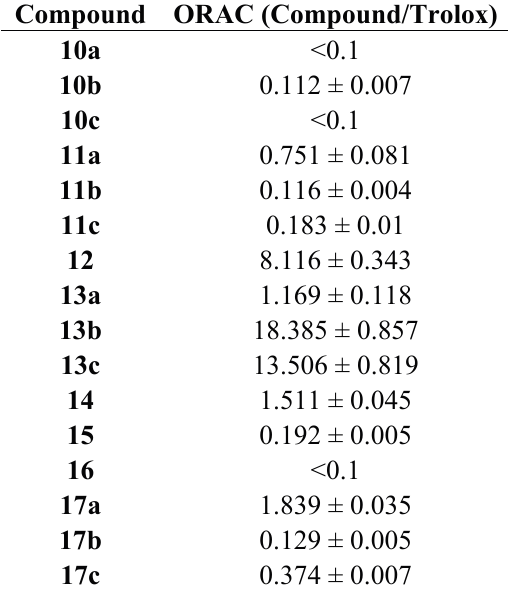
Table 3. Oxygen radical absorbance capacity given as ratio between compound and Trolox on an equimolar basis. Data are expressed as mean ± SD ( n =